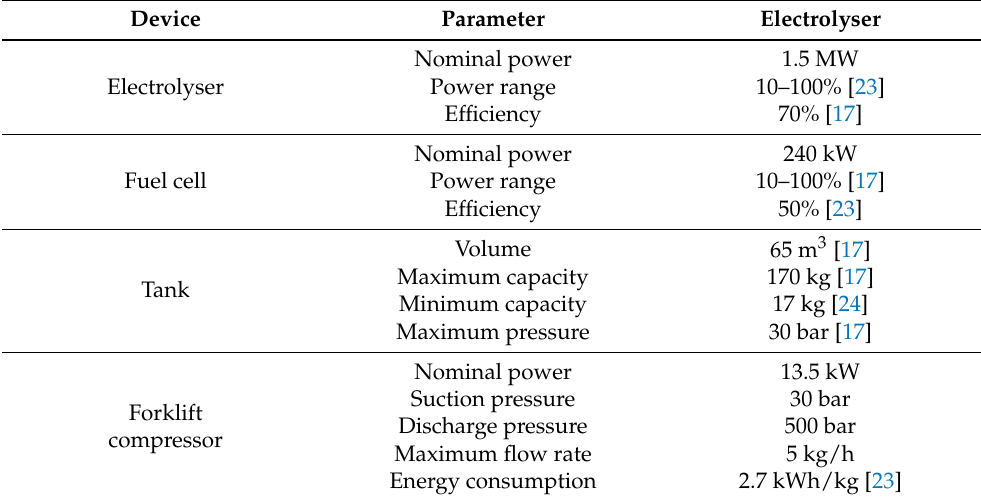
Table 2. Technical characteristics of the H 2 PP